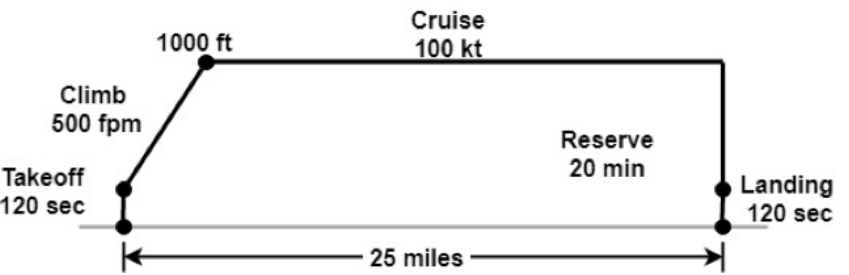
Figure 5. Baseline mission profile used for sweep of